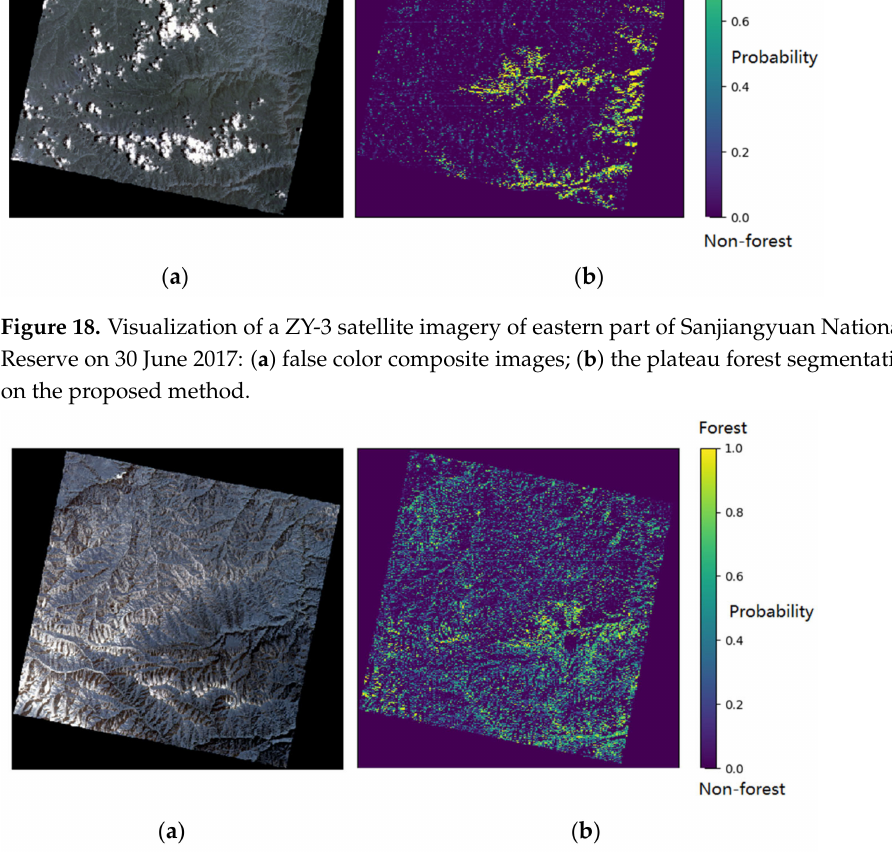
Figure 19. Visualization of a ZY-3 satellite imagery of Eastern part of Sanjiangyuan National Nature Reserve, on 9 January 2017: ( a ) false color composite images; ( b ) the plateau forest segmentation based on the proposed